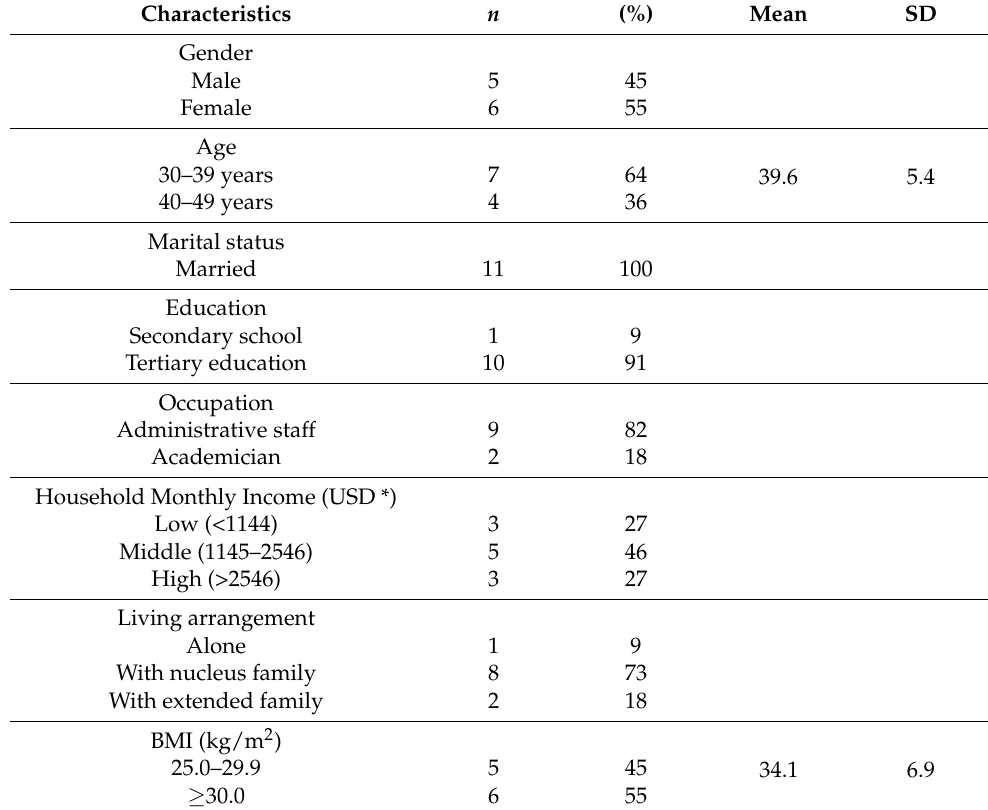
Table 2. Participants’